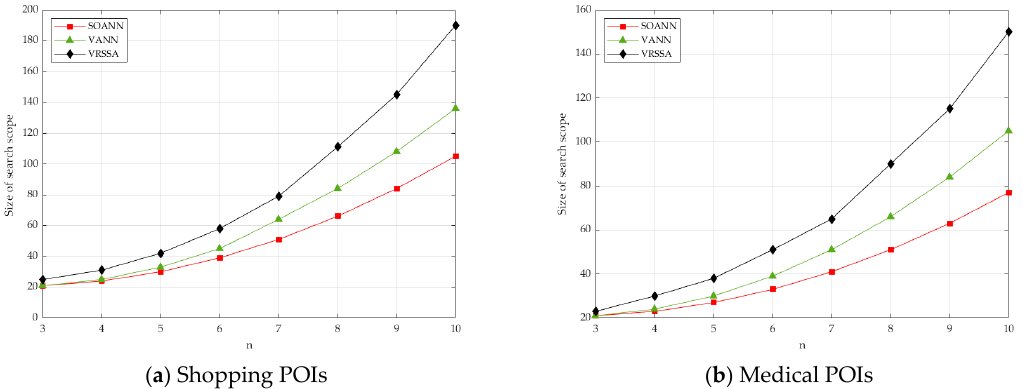
Sensors 2019 Figure 17. The effect of number of users on the searching set size. Figure 17. The e ff ect of number of users on the searching set size.